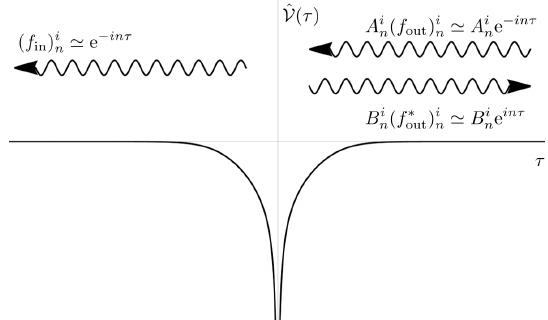
Figure 3 . The replaced potential ˆ V for an example A ( u ) = − κ/ | u | β and boundary conditions to obtain the Bogoliubov